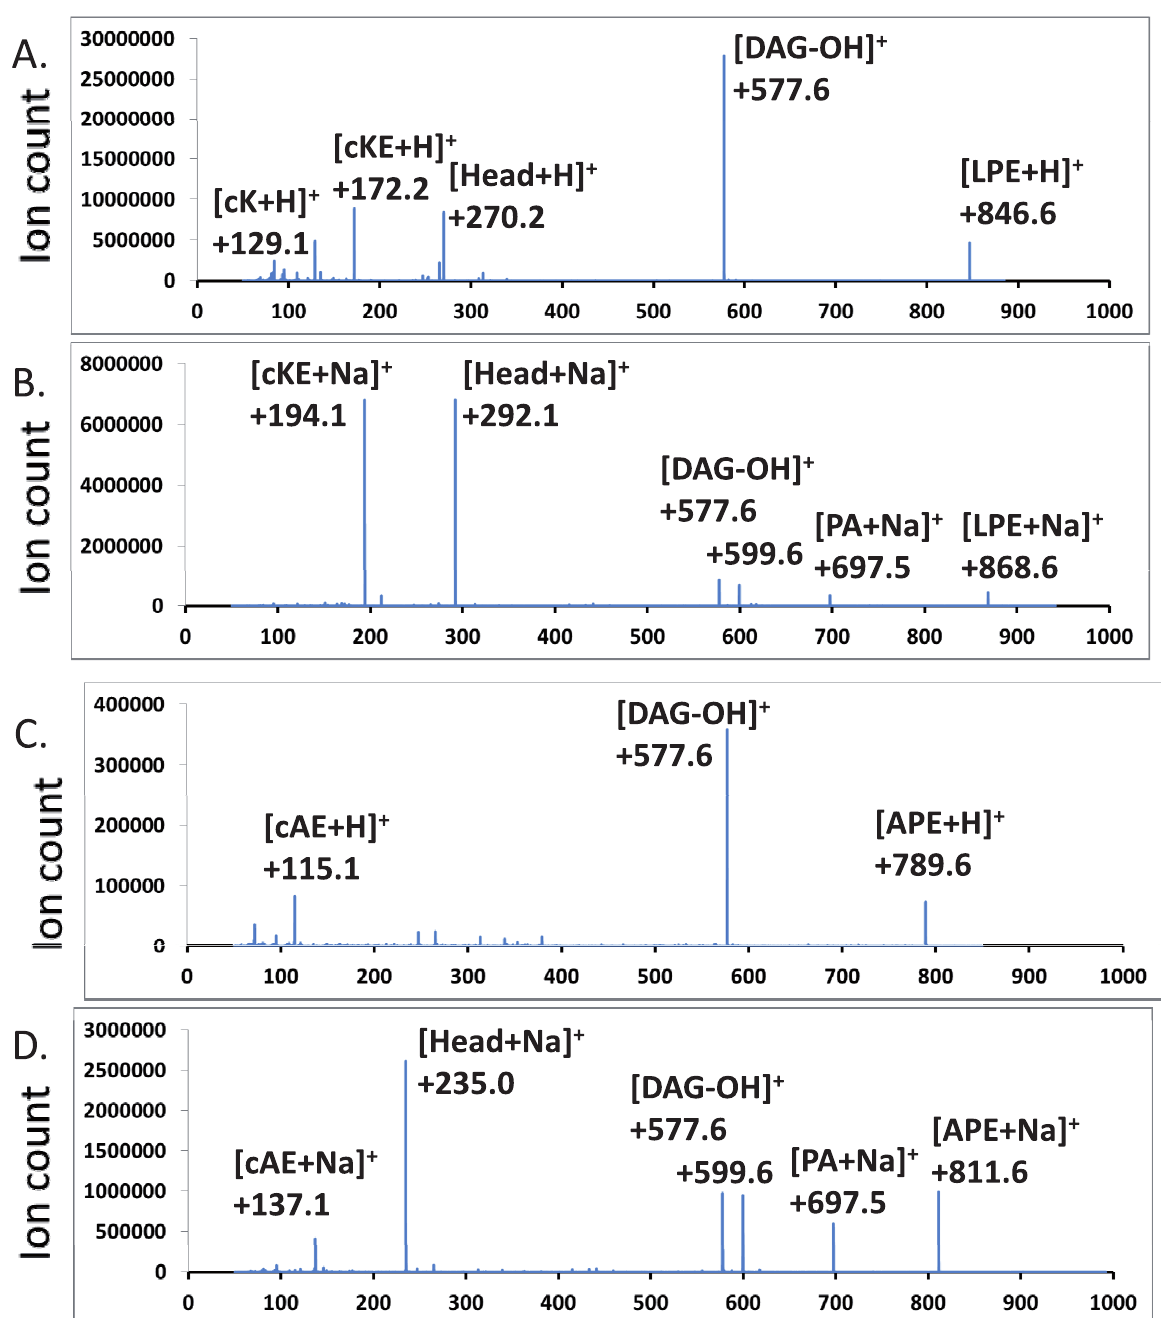
Figure 5. MS/MS spectra of chemically synthesized lysyl-PE and alanyl-PE. Protonated and sodiated ions are shown. LPE – (16:0–18:1) lysyl-PE, APE – (16:0–18:1) alanyl-PE, PA – phosphatidyl acid, DAG – diacylglycerol, Head – head group, cAE – cyclo-alanyl-ethanolamine, cK – cyclo-lysine, cKE – cyclo-lysyl-ethanolamine. A & B . Lysyl-PE. C & D .